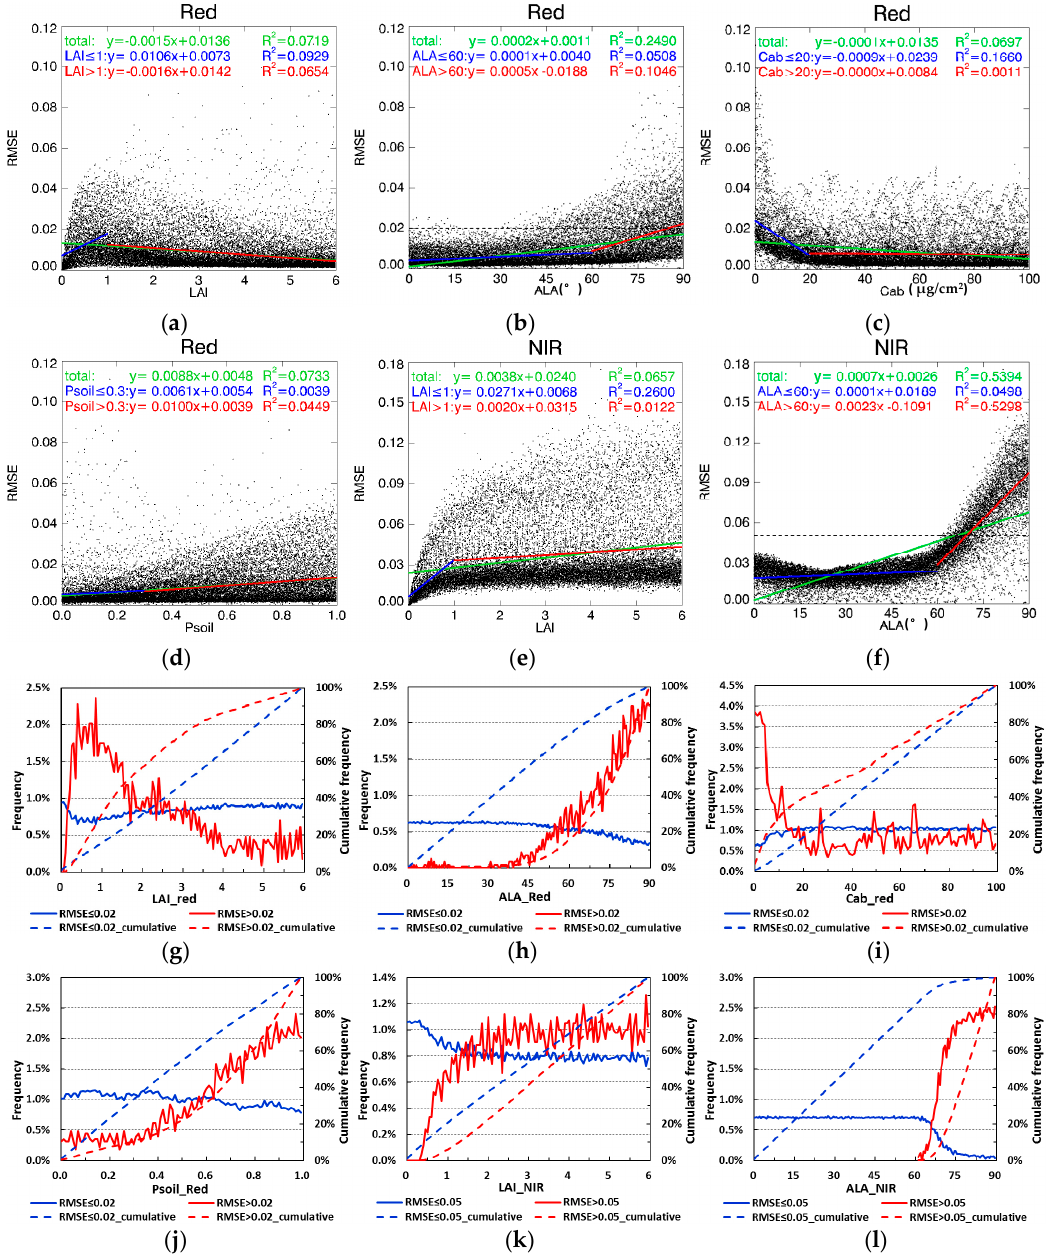
Figure 5. Sensitivity of fit-RMSE to vegetation components: ( a – f ) relationships between vegetation parameters and fit-RMSE and ( g – l ) the normalized histograms of vegetation parameters inside (blue line, 88.6% [red band] and 79.0% [NIR band] in total) and outside (red line) of the RMSE tolerance, as in Figure 3c, where the ordinate values are the percentages of each total proportion.